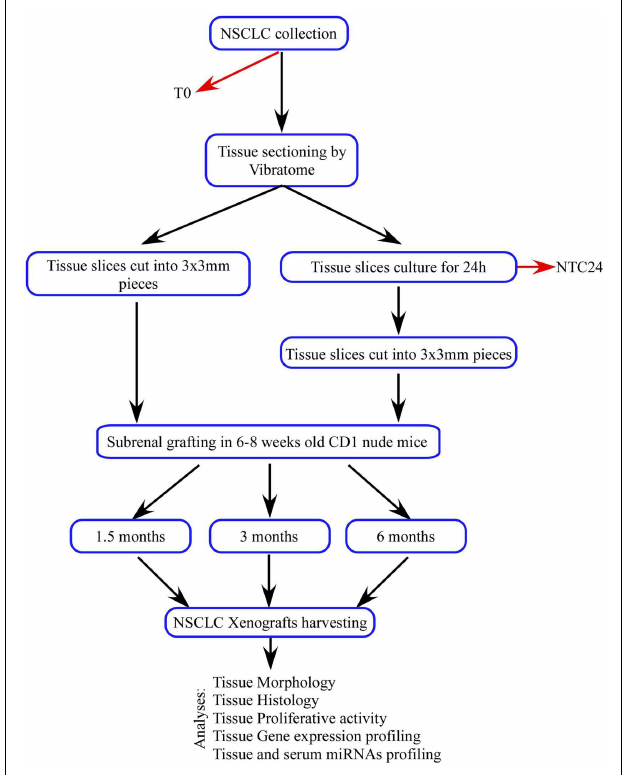
FIGURE 1 | Schematic overview of the experimental design